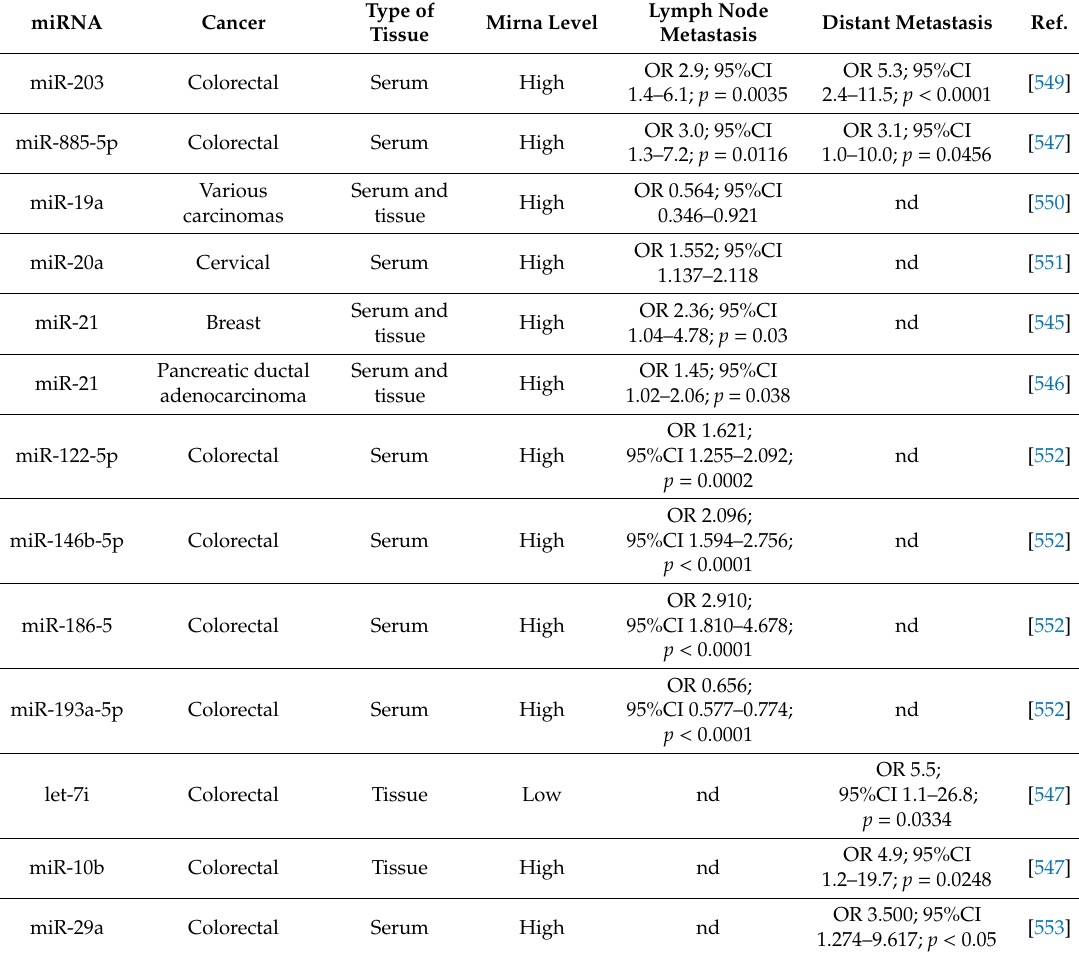
Table 8. MiRNAs as biomarkers of